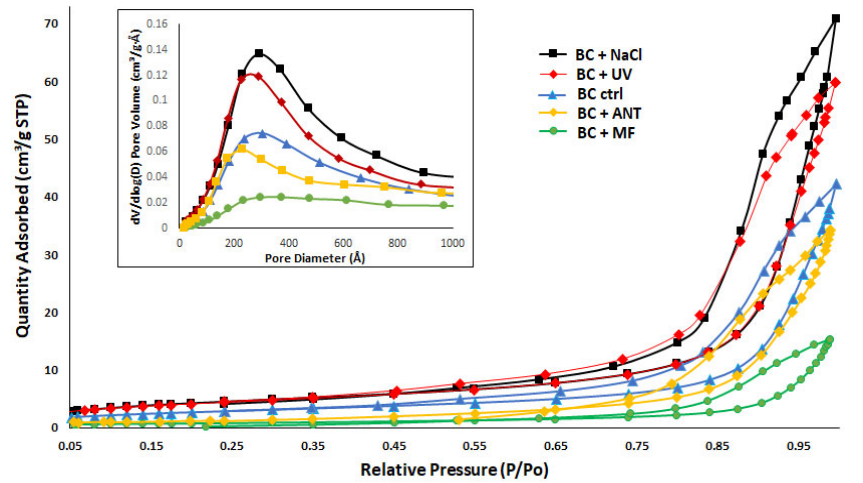
Figure 2 . Nitrogen adsorption–desorption isotherms (inset: pore size distribution graph). Figure 2. Nitrogen adsorption–desorption isotherms (inset: pore size distribution